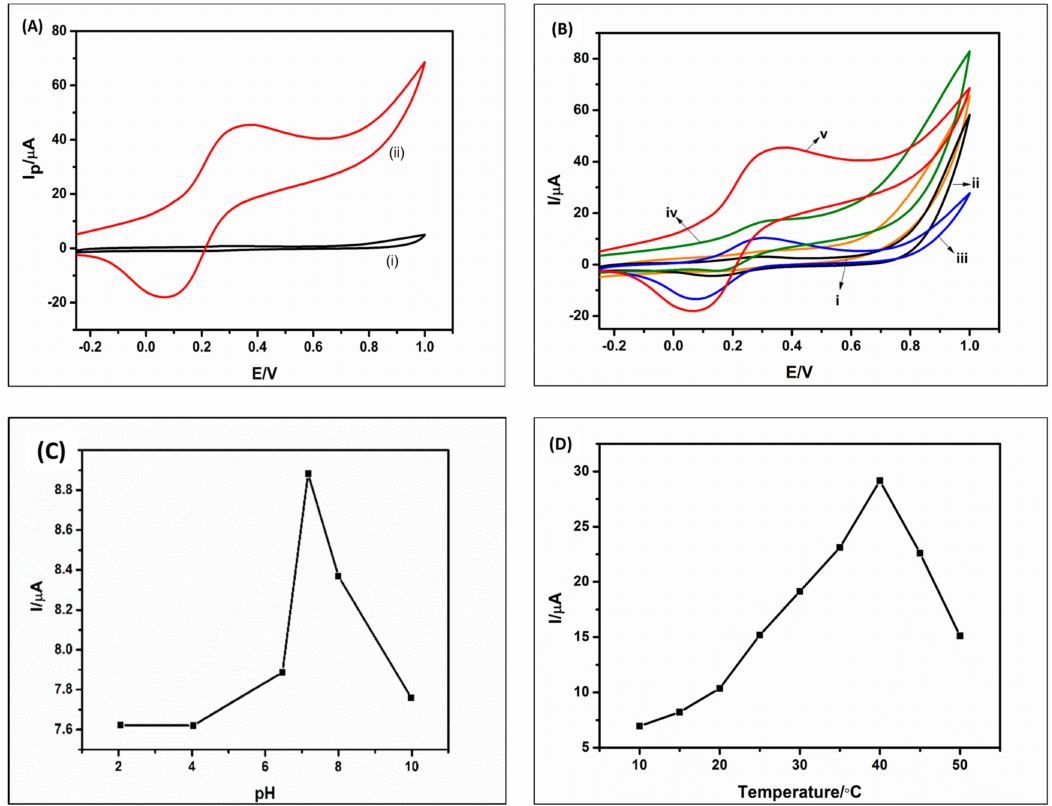
Figure 5. Cyclic voltammograms of GCE/PPI/QDs/ChOx in PBS (i) and in 10 mM cholesterol solution (ii) ( A ); Cyclic voltammograms of GCE/QDs (i), GCE/PPI (ii), GCE/PPI/ChOx (iii) GCE/QDs/ChOx (iv) and GCE/PPI/QDs/ChOx (v) in 10 mM cholesterol solution at 50 mV.s − 1 ( B ); Effect of pH ( C ); and temperature ( D ) on the developed biosensor.3.5. Electrochemical Detection of Cholesterol